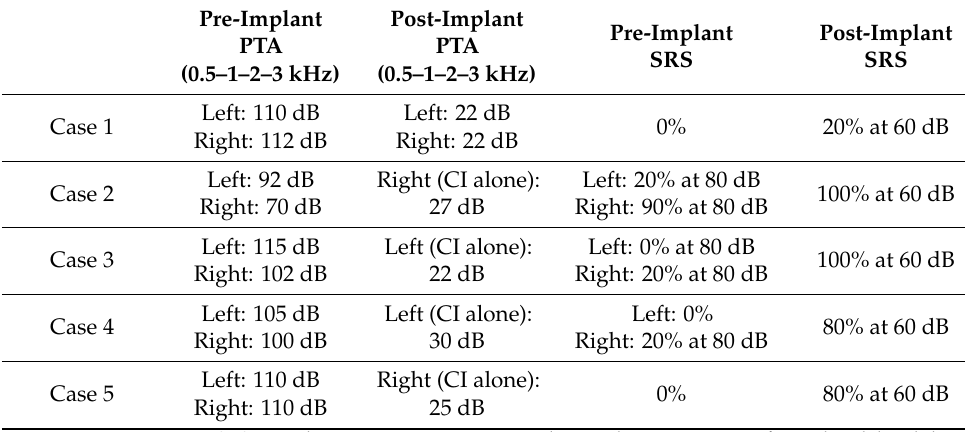
Table 1. Auditory outcomes before and after cochlear implant